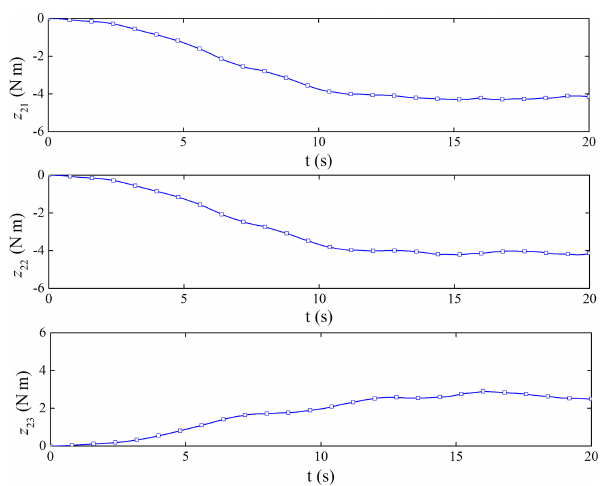
Figure 18. Estimated disturbance.